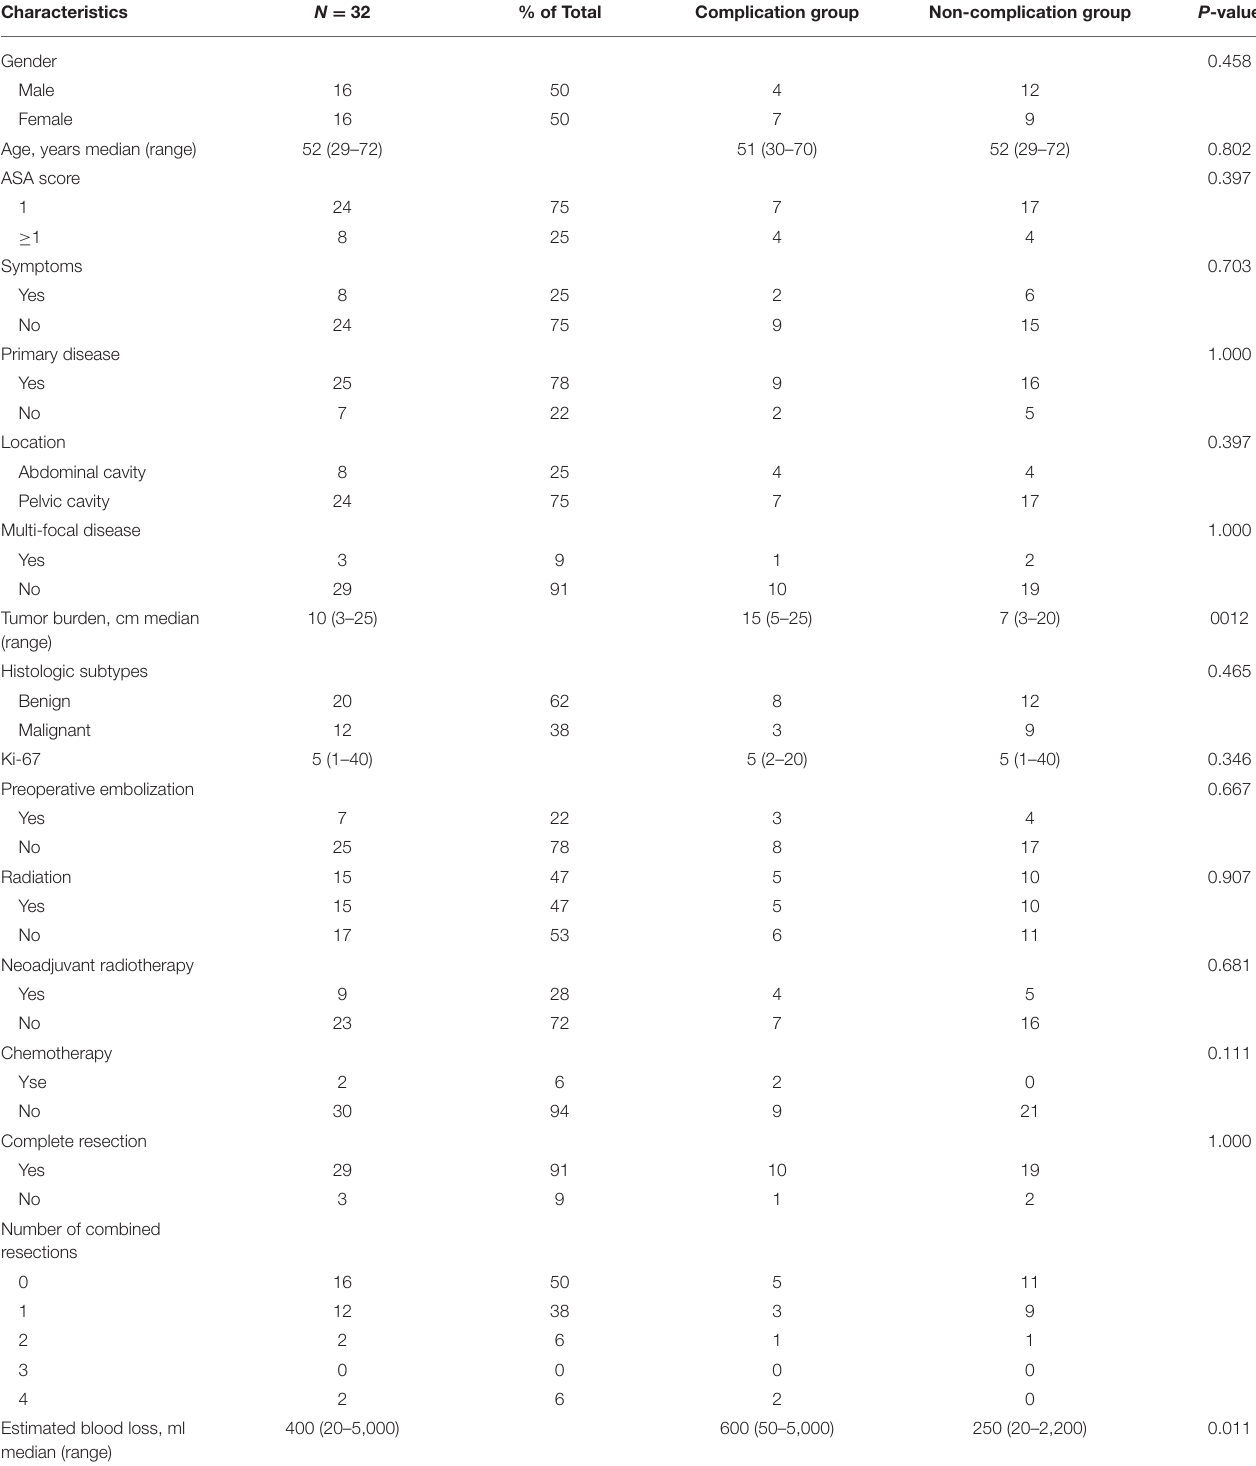
TABLE 1 | Patient and tumor characteristics in 32 patients with retroperitoneal solitary fibrous tumor.